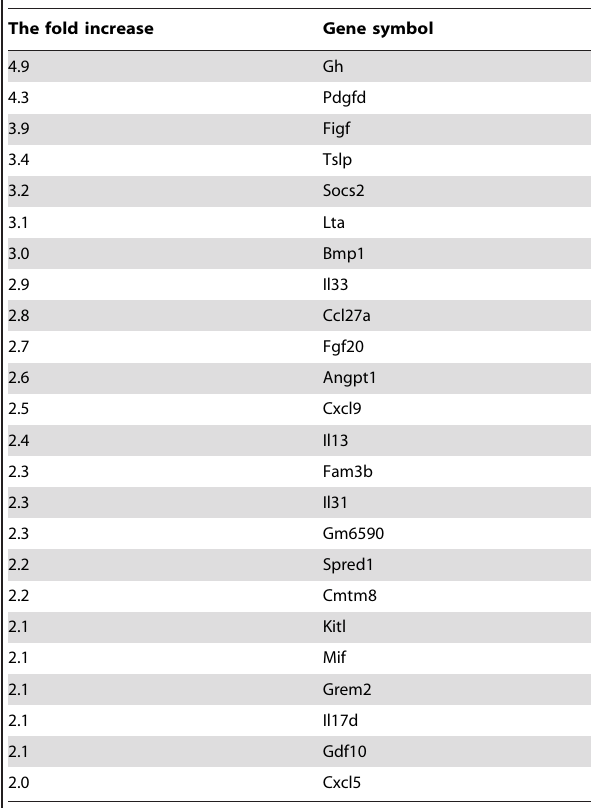
Table 1. DNA microarray